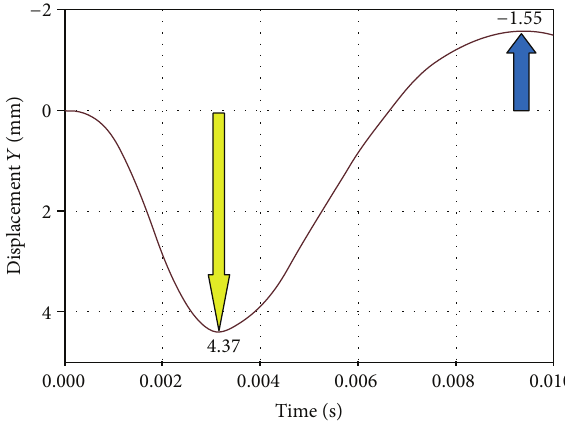
Figure 6: Dislocation evaluated in point A in relation to the time after a